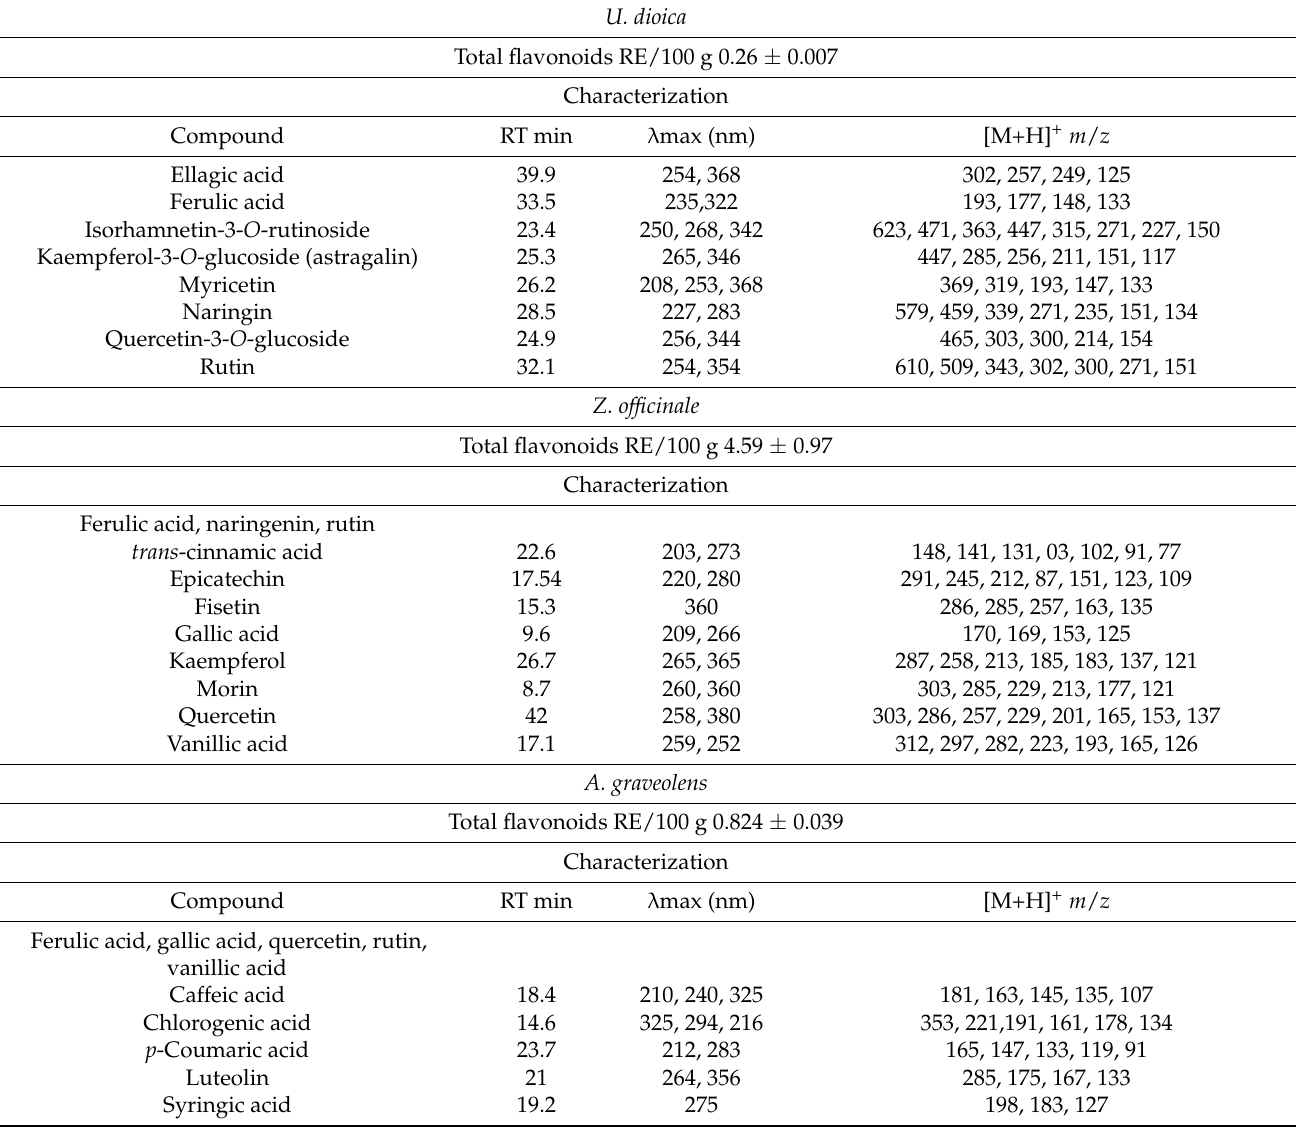
Table 1. Identification and characterization of the flavonoids and phenolic acids from U. dioica, Z. officinale , and A. graveolens